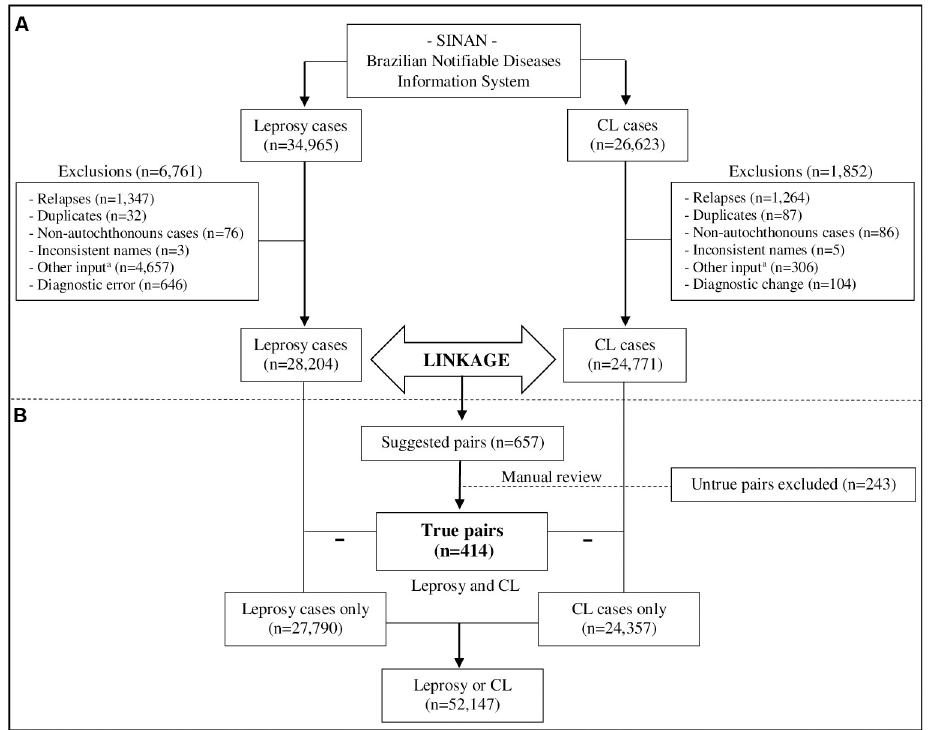
Fig 1. Identification of the study population. (A) Exclusion criteria. (B) Linkage between leprosy and cutaneous leishmaniasis (CL) datasets from the Brazilian Notifiable Diseases Information System (SINAN). Data from Mato Grosso state, Brazil, 2008–2017. a Transfers (within the municipality, from another municipality, from another state, or from another country), unknown, or cases reinserted in the system for a new treatment round after abandonment or therapeutic